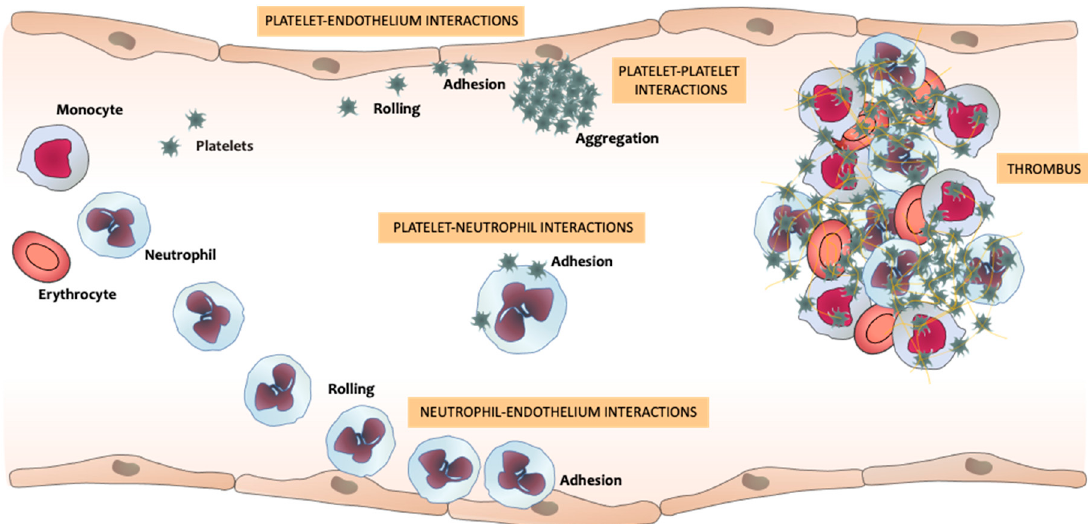
Figure 1. Neutrophils’, platelets’, and endothelial cells’ interactions that promote the transition from inflammation to thrombosis. Upon an inflammatory signal, neutrophils circulating across the vessels reduce their flow velocity and start rolling along endothelial cells, eventually adhering to them. This process can induce the activation and recruitment of further neutrophils, in addition to endothelium activation or dysfunction, which can trigger platelet adhesion to the endothelium and to neutrophils. The interactions between these three types of vascular cells, and with circulating monocytes and erythrocytes, trigger the thrombus formation that can produce vessel occlusion.